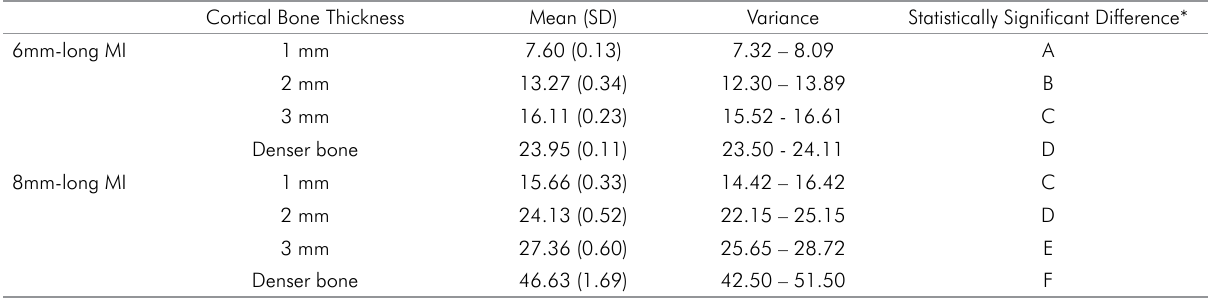
Table 1. Mean, standard deviation and variance of insertion torque values of 6mm- and 8mm-long mini-implants (N.cm) in the different cortical bone thicknesses tested and statistically significant differences among the groups according to the Tukey’s post hoc